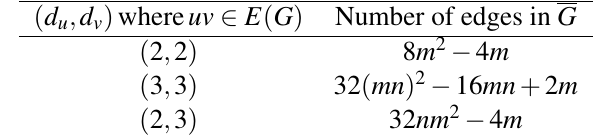
Table 7 The edge partitions m ij of G based on the vertex degrees of G